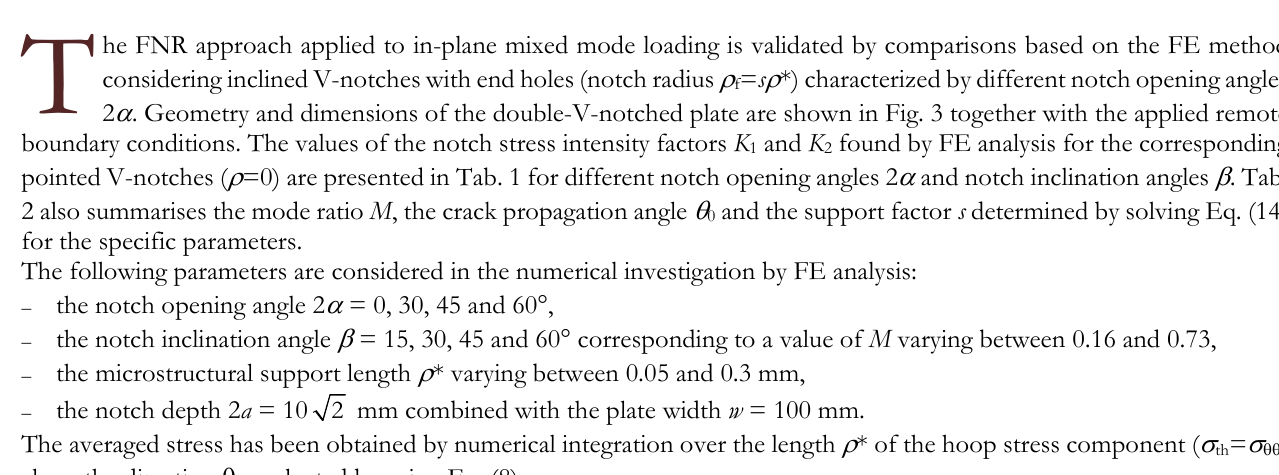
V ALIDATION OF THE PROPOSED FNR APPROACH FOR MIXED MODE LOADING